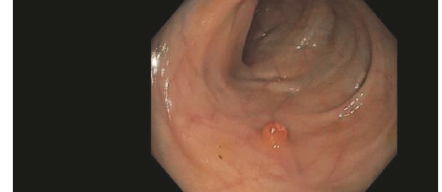
Figure 1: Original video frame.